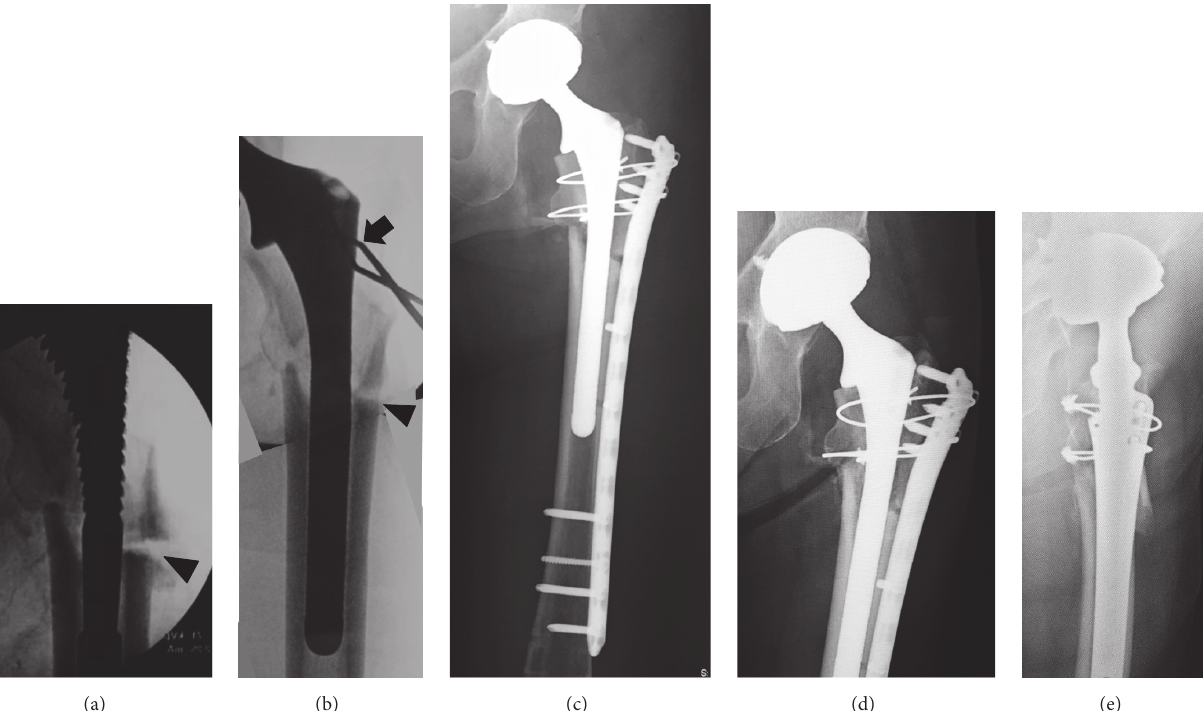
Figure 2: (a) A trial broach with the optimum size was inserted, but reduction was not enough (arrowhead). (b) Varus of the proximal bone fragment was prevented using the Blocking Pin Technique (arrow), and the stem was placed in the optimal position (arrowhead). (c) The osteosynthesis-combined one-staged total hip arthroplasty. (d) AP and lateral views on radiograph obtained after second surgery six months show complete union of the